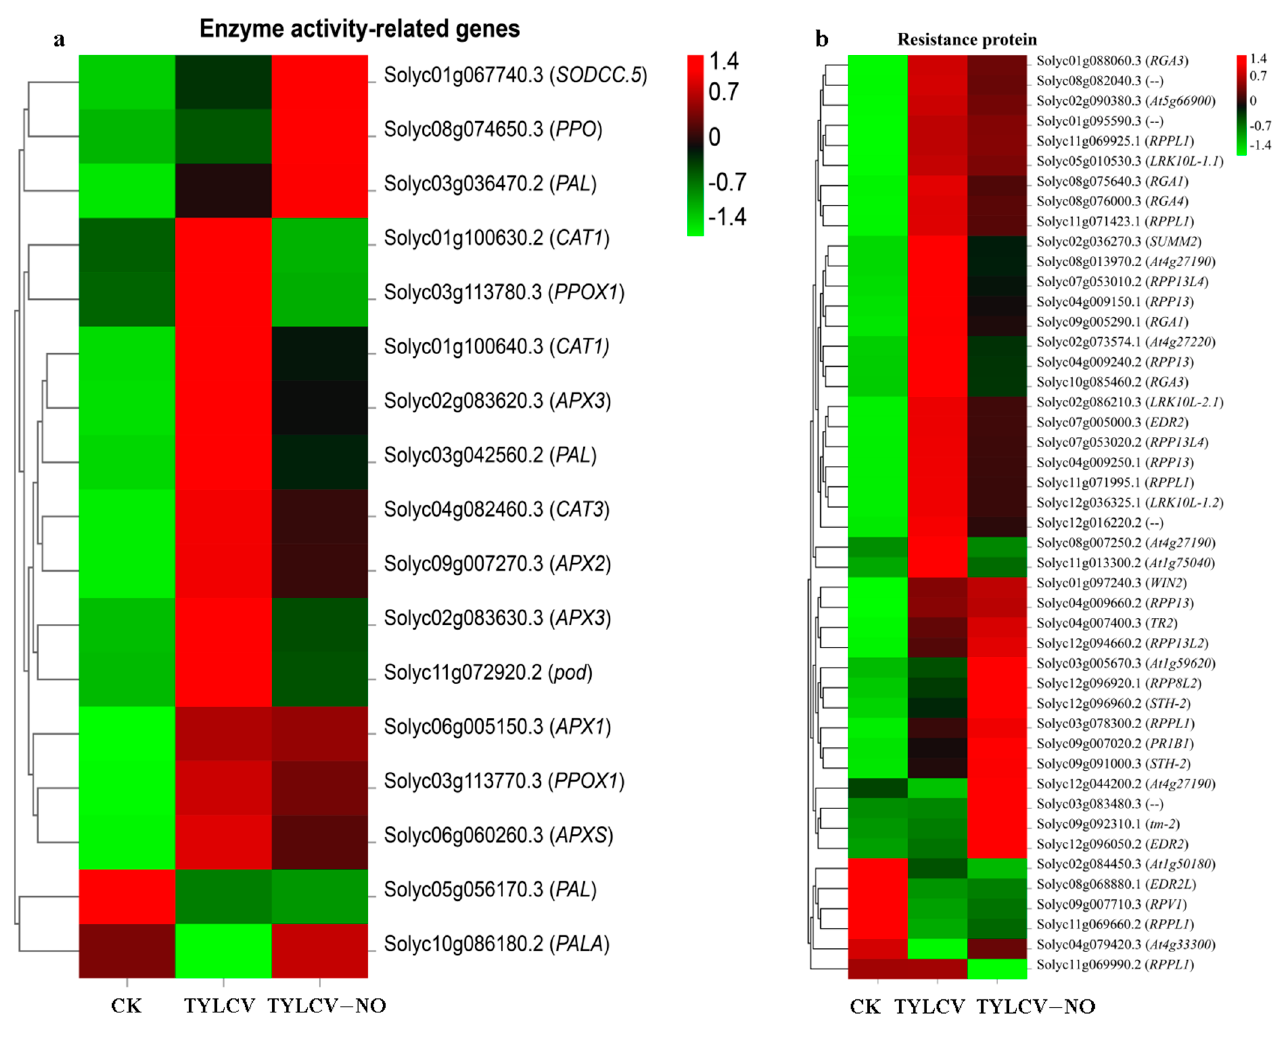
Figure 5. ( a ) Heat map shows the resistance gene expression in tomato. The number of sequenced counts of all genes in the graph is greater than 50; ( b ) Heat map showing expression of genes associated with antioxidant enzyme/defense enzyme in tomato, Different colors indicate the expression level of each gene after normalization by FPKM.2.4.5 exogenous NO-mediated disease resistance proteins.